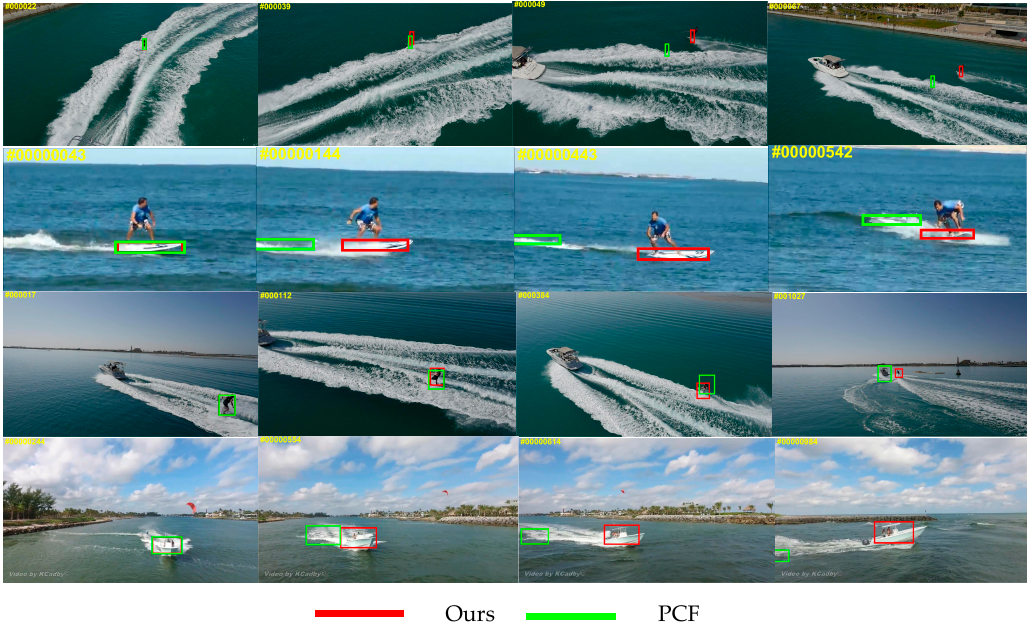
Figure 2. Comparison results of the proposed tracker and the baseline tracker PCF in the complex marine environment.